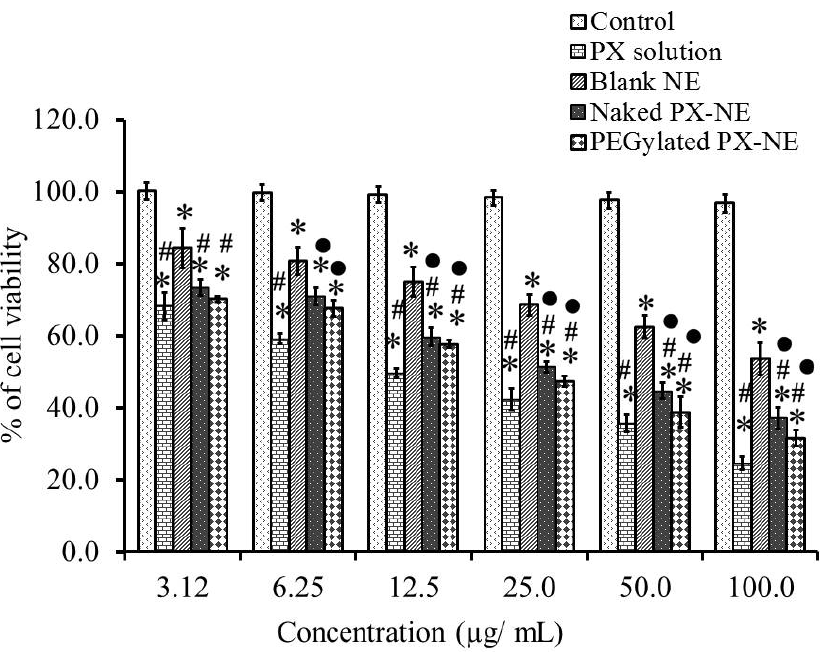
Figure 9. Cell viability of MDA-MB-231 cancer cells upon using naked and PEGylated PX-NE formulations compared with blank NE and PX solution. Data are represented as mean ± SD. * p < 0.05, compared to control, # p < 0.05, compared to blank NE, and • p < 0.05, compared to PX solu- tion.